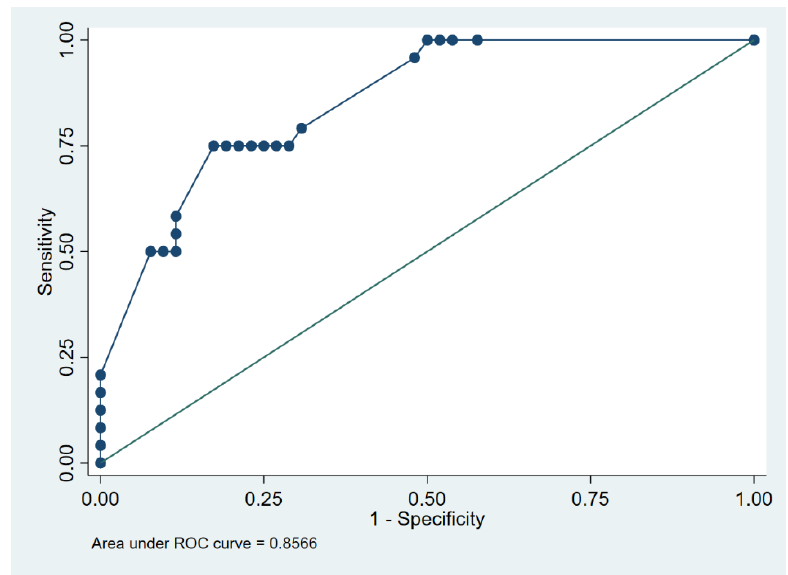
Figure 5. Receiver operating characteristic (ROC) curves determine the degree of phlebitis (absent–mild phlebitis vs. moderate–severe phlebitis) and indwelling time of catheters in dogs. Table 5. Sensitivity and specificity of different cut ‐ off points to prevent the onset of moderate ‐ to ‐ severe phlebitis in dogs.